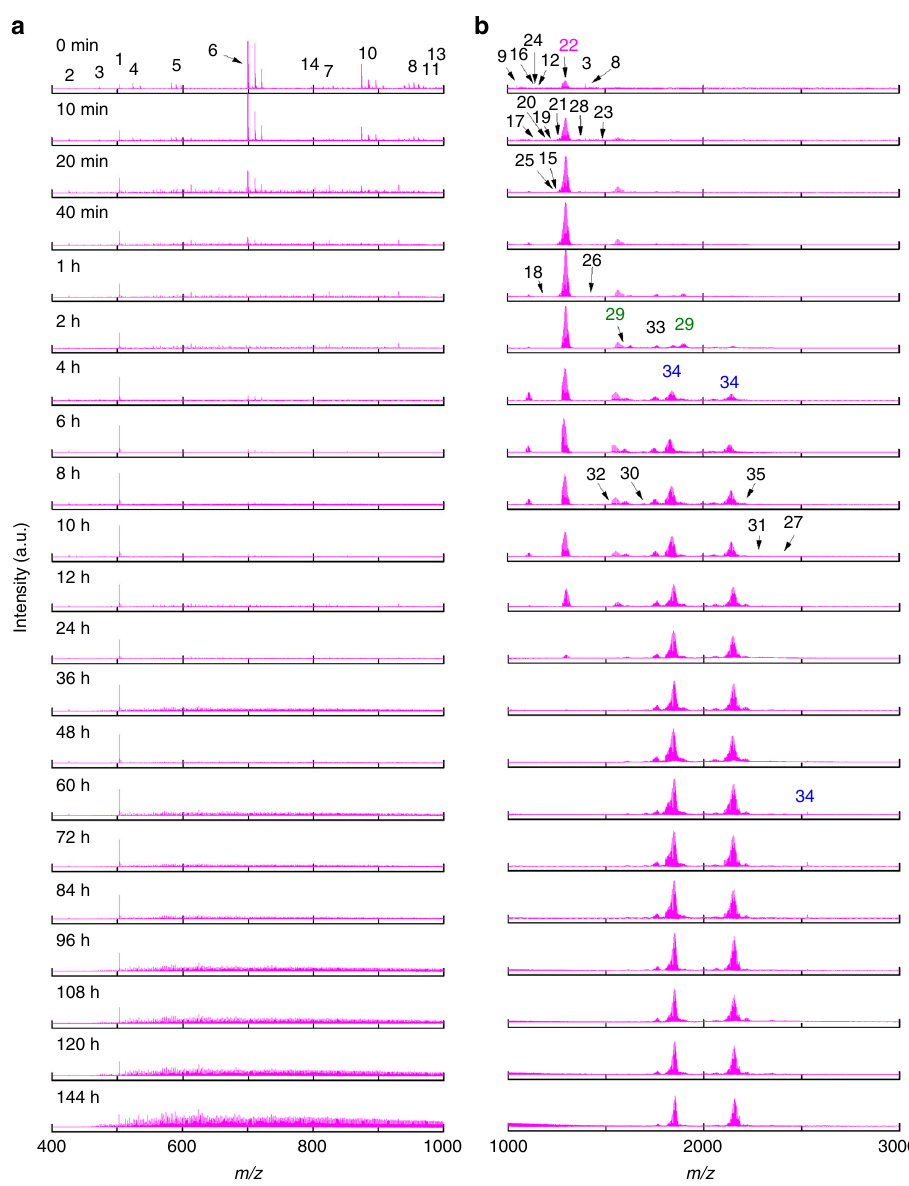
Fig. 3 Monitoring size growth by electrospray ionization mass spectrometry. Time-course electrospray ionization mass spectra of size growth reaction from [Au 25 (SR) 18 ] − to [Au 44 (SR) 26 ] 2 − in a low and b high m/z regime. For ease of identi fi cation, the starting cluster [Au 25 (SR) 18 ] − , product cluster [Au 44 (SR) 26 ] 2 − , as well as an important intermediate cluster [Au 38 (SR) 24 ] 0 are highlighted in magenta, blue, and olive, respectively. The detailed formula of Au(I)-SR complexes or cluster intermediates identi fi ed in mass spectrometry are listed in Table